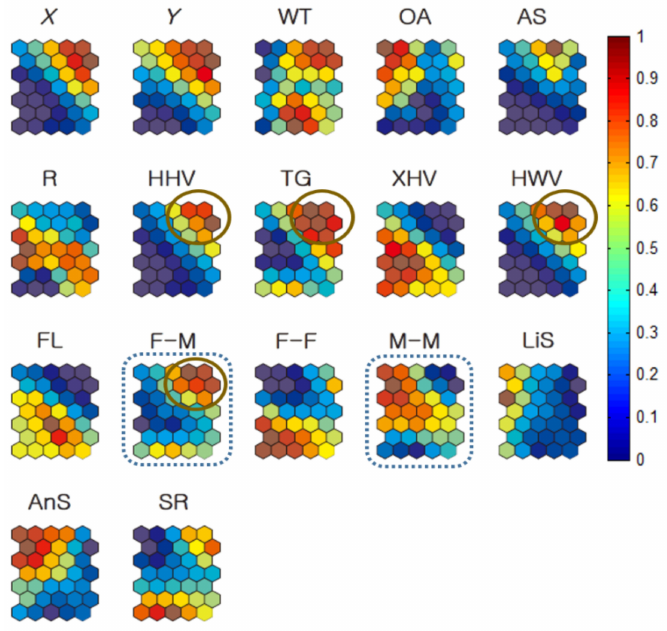
Figure 11. Co-occurrence of nutria individuals within 250 m distances in association with habitat types and locations for all individuals ( k = 3). All values in the component maps were normalized between 0.0 and 1.0, as shown on the vertical bar. Water temperature: WT; open area: OA; artificial structure: AS; road: R; hydric herbaceous vegetation: HHV; tall grassland: TG; xeric herbaceous vegetation: XHV; hydric woody vegetation: HWV; floating-leaved hydrophytes: FL; sex ratio: SR; female–male co-occurrence: F-M; female–female co-occurrence: F-F; male–male co-occurrence: M-M; linear speed: LiS; angular speed: